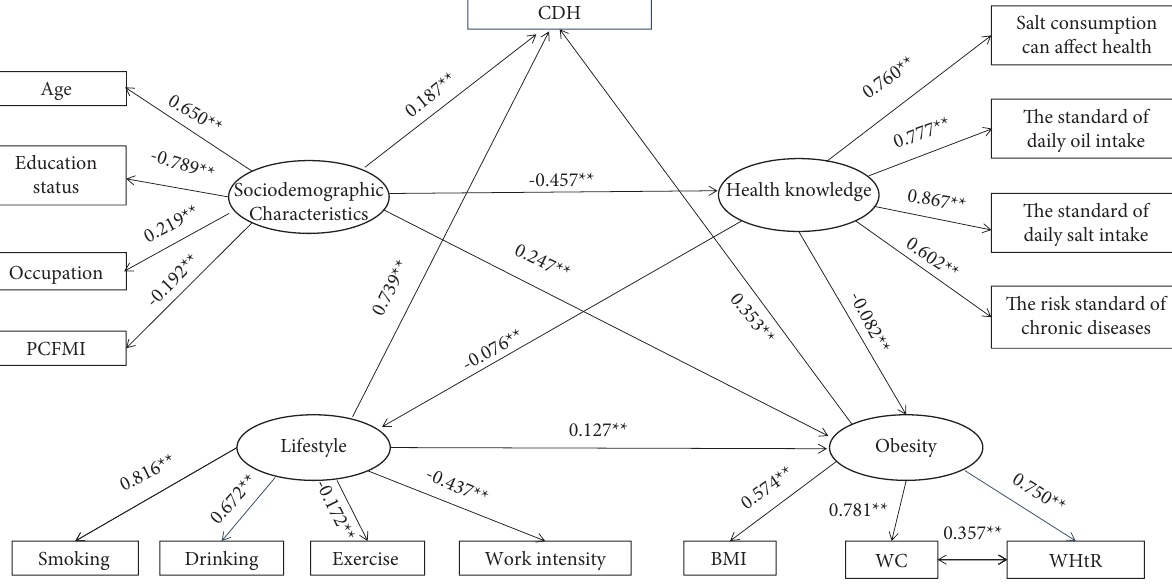
Figure 3: The structural equation model of sociodemographic characteristics, lifestyle, obesity, health knowledge, and HDC. Note . ∗∗ P < 0 . 001 (two-tailed test). All path coefficients shown were standardized. CDH: coexistence of diabetes and hypertension; PCFMI: per capita family monthly income; BMI: body mass index; WC: waist circumference; and WHR: waist-to-height